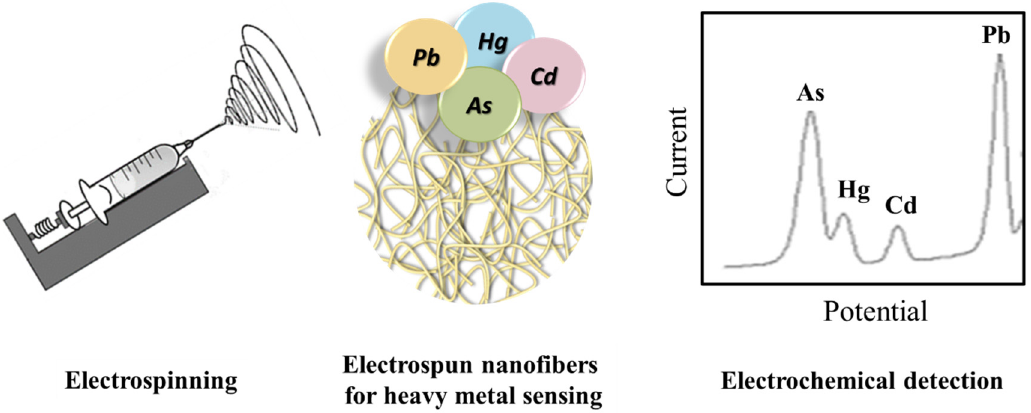
Figure 6. Representative sketch of the analyzed combined system.